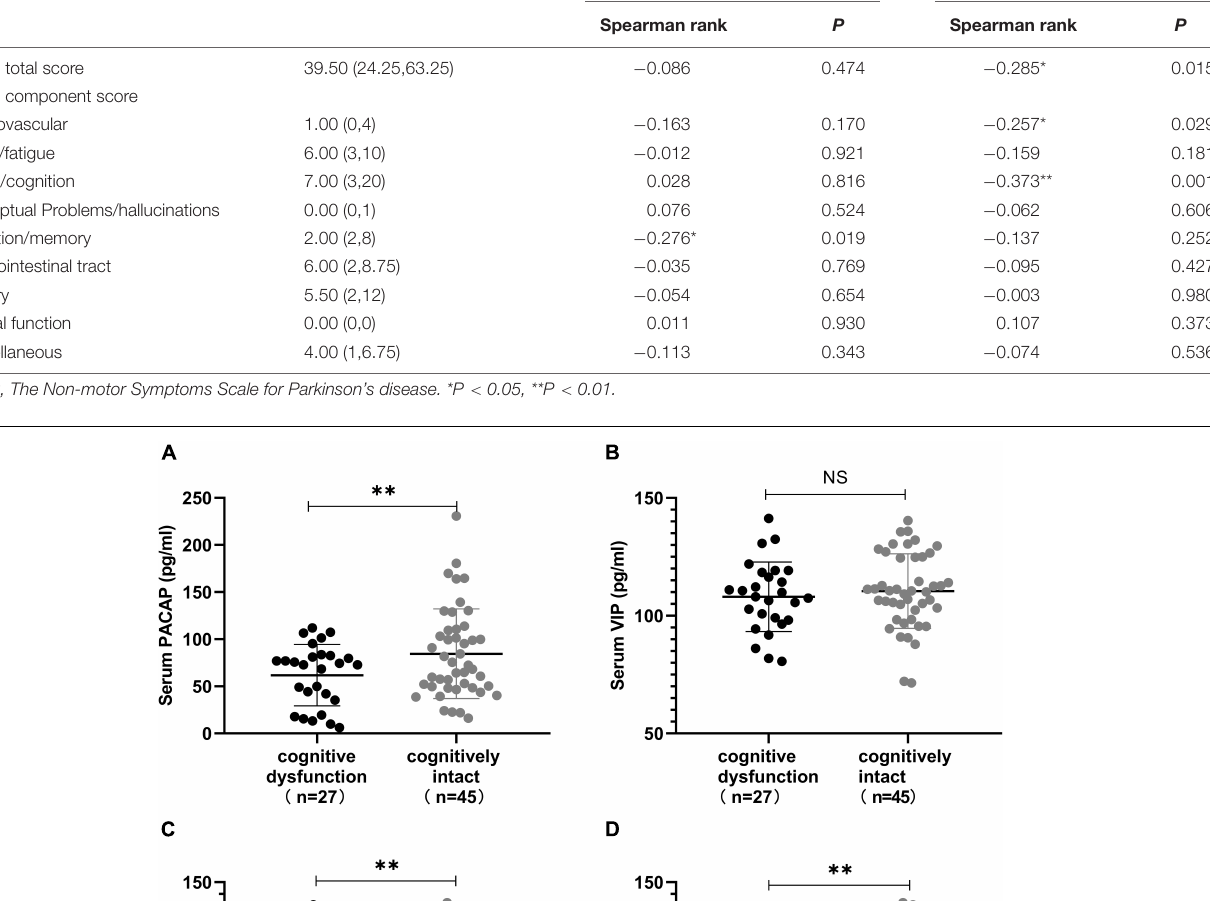
TABLE 2 | Correlation analysis of non-motor symptoms and serum PACAP and VIP levels in PD patients. Medians (quartile ranges)